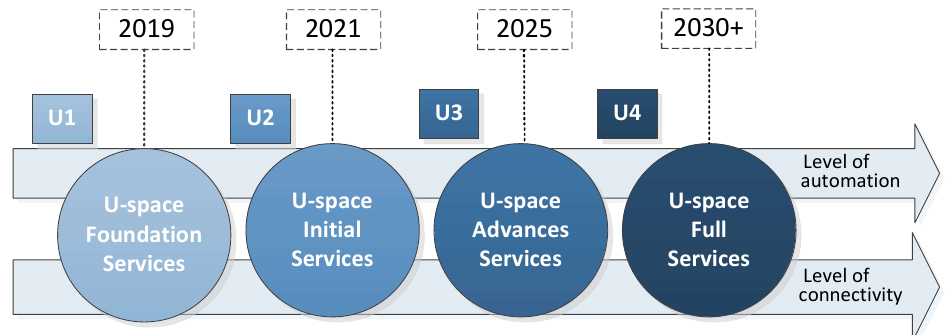
Figure 3. The implementation roadmap for the U-space initiative [13], consisting of 4 deploy- ment